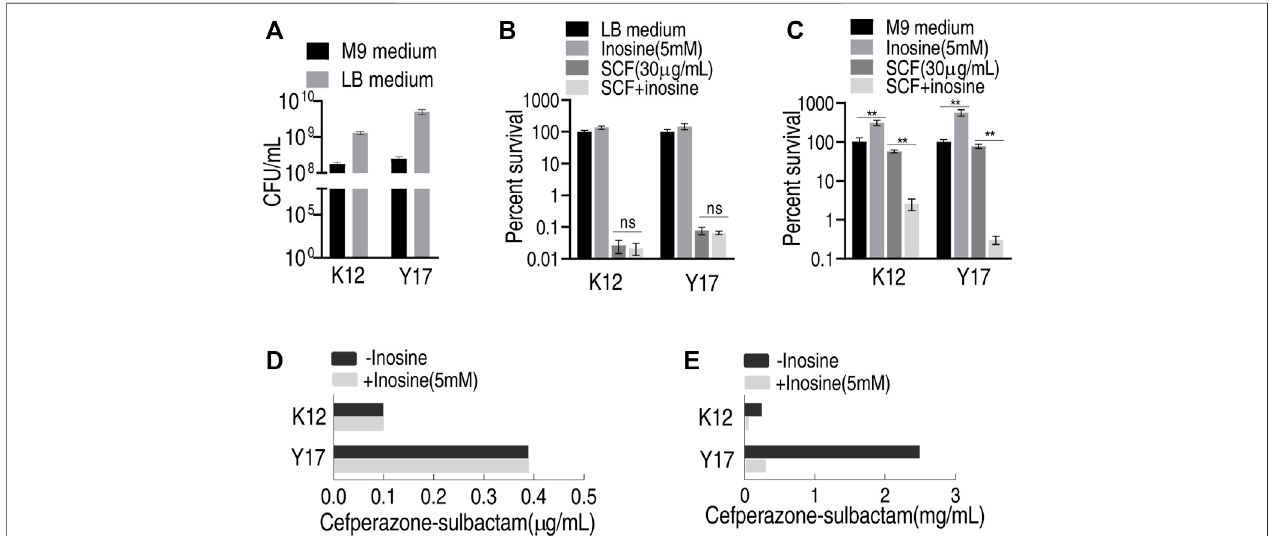
FIGURE1| Effectofinosineindifferentmedium (A) ViabilityofK12andY17inLBmediumandM9mediumat37 ° Cfor6 h (B) PercentsurvivalofK12andY17inLB medium with and without 5 mM inosine plus SCF (C) Percent survival of K12 and Y17 in M9 medium with and without 5 mM inosine plus SCF (D) MIC test of K12 and Y17 in LB medium with and without 5 mM inosineplus SCF (E) MKC test ofK12 and Y17 inM9 medium with and without5 mM inosine plus SCF. Results are displayed as mean ± SEM and three biological repeats are performed. Signi fi cant differences are identi fi ed * p < 0.05, ** p < 0.01.